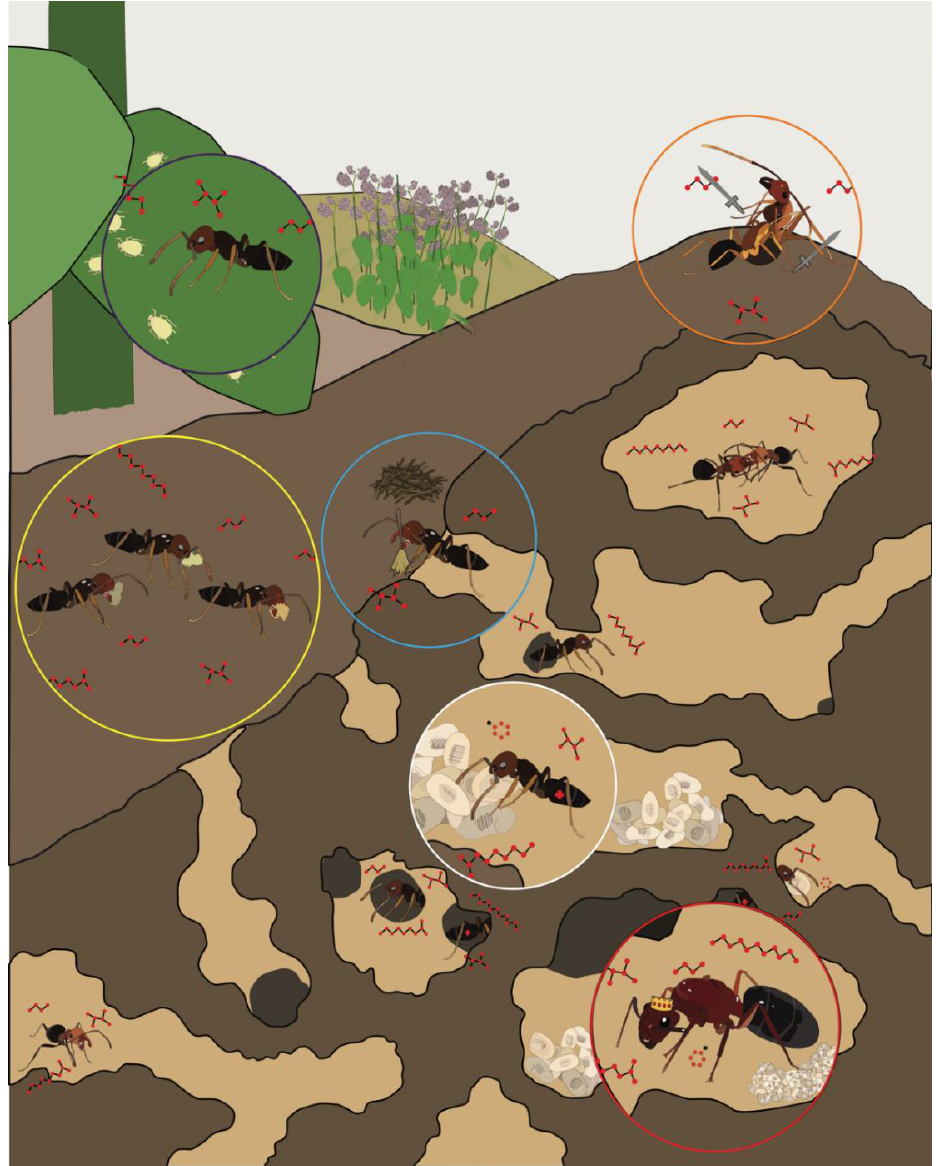
Figure 1. The regulation of complex social behaviors in ant colonies relies on the transmission and detection of chemical information among discrete castes and worker groups, including reproductive “queen(s)” (red circle), brood-care “nurses” (white circle), cleaning “midden workers” (blue circle), food collecting “foragers” (yellow circle), aphid-tending “farmers” (purple circle), and colony defending “soldiers” (orange circle).